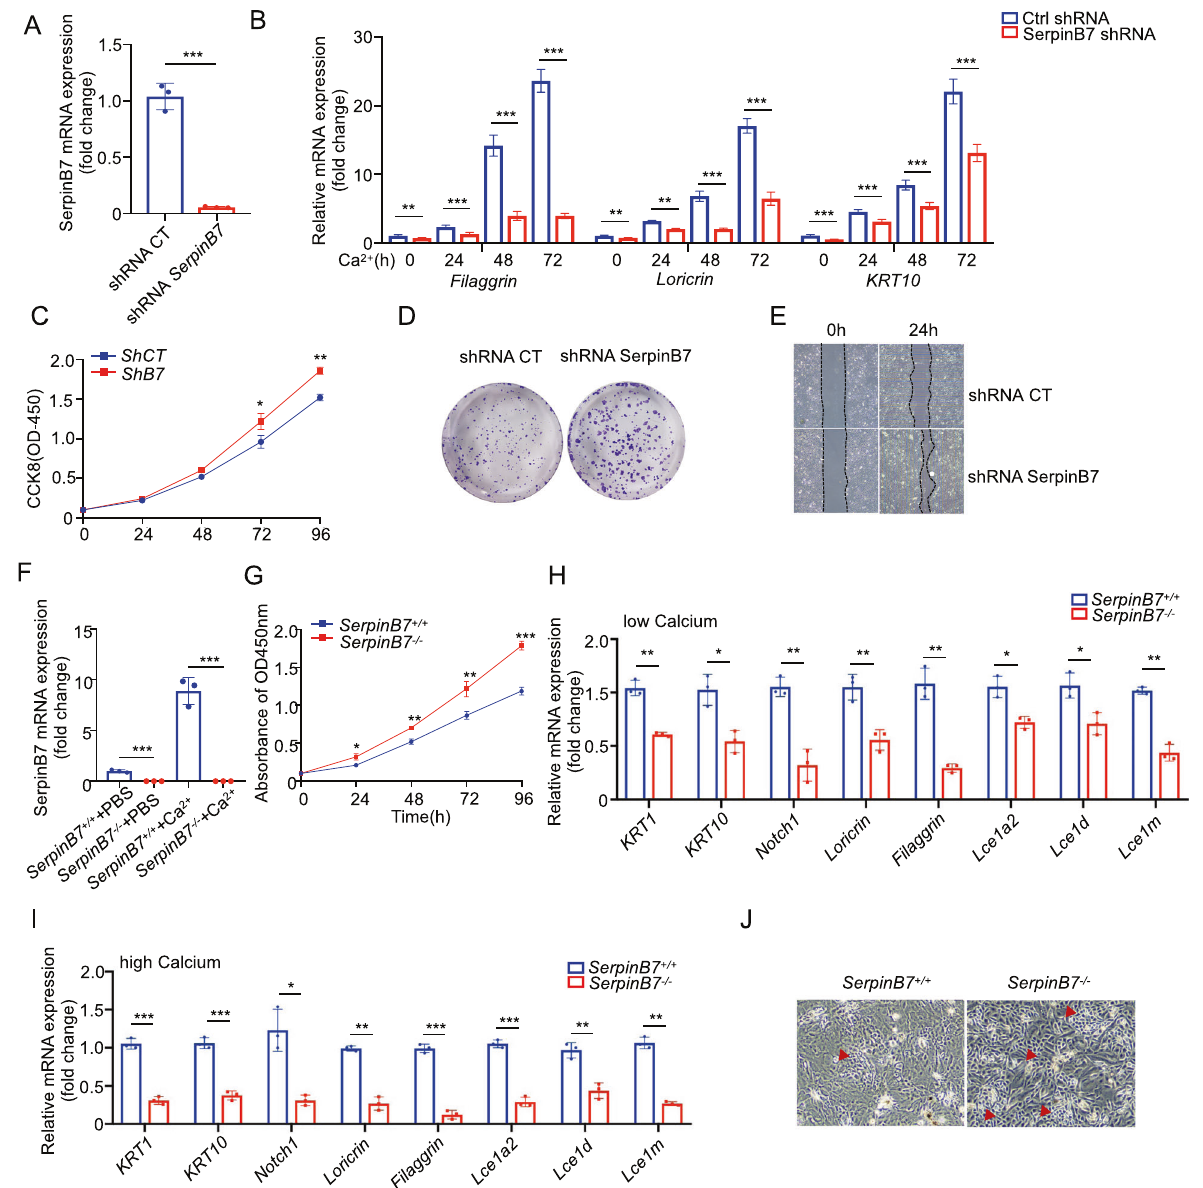
Fig. 4 SerpinB7 de fi ciency promotes proliferation and suppresses differentiation in keratinocytes. A NHEK cells were transfected with shCT and sh-SerpinB7. The mRNA level of SerpinB7 was measured by RT-PCR. B CaCl 2 -induced Filaggrin, Loricrin, and KRT10 expression in shCT and sh-SerpinB7 NHEKs at 0 – 72 h was measured by RT-PCR. C , D The proliferation of sh-SerpinB7 keratinocytes was evaluated with a CCK8 (Cell Counting Kit 8) assay and colony formation assay. E Identical fi elds scratch of undifferentiated sh-SerpinB7 and control NHEKs at 0 and 24 h. The dotted line represents the area of the scratch. F The mRNA level of SerpinB7 in Serpinb7 -/- and Serpinb7 + / + mice primary keratinocytes (MKs) was measured by RT-PCR. G The proliferation of SerpinB7 + / + and Serpinb7 -/- MKs was evaluated with a CCK8 assay. H , I SerpinB7 + / + and Serpinb7 -/- MKs homeostasis and treated for 24 h with 1.6 mM CaCl 2 + were analyzed by RT-PCR for the expression of early ( Krt1, Krt10 ) and late ( Notch1, Loricrin, Filaggrin, Lce1a2, Lce1d, Lce1m ) differentiation genes. J Morphology of SerpinB7 + / + and Serpinb7 -/- MKs in response to Ca 2 + induced differentiation, red arrow indicated typical undifferentiated keratinocyte state. Mean ± SD. * P < 0.05; ** P < 0.01; *** P < 0.001. Two-tailed Student ’ s t -test ( A , H , I ), one-way ANOVA ( B , C , F , G ). All the data are representative of three independent